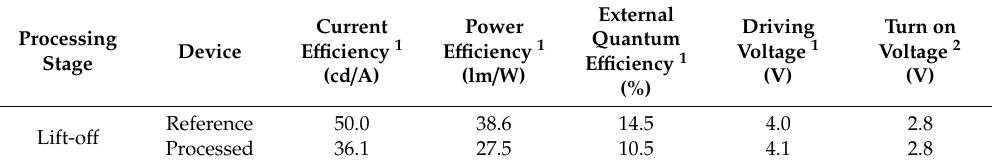
Table 2. Performance summary of a reference device and a processed device after lift-o ff .